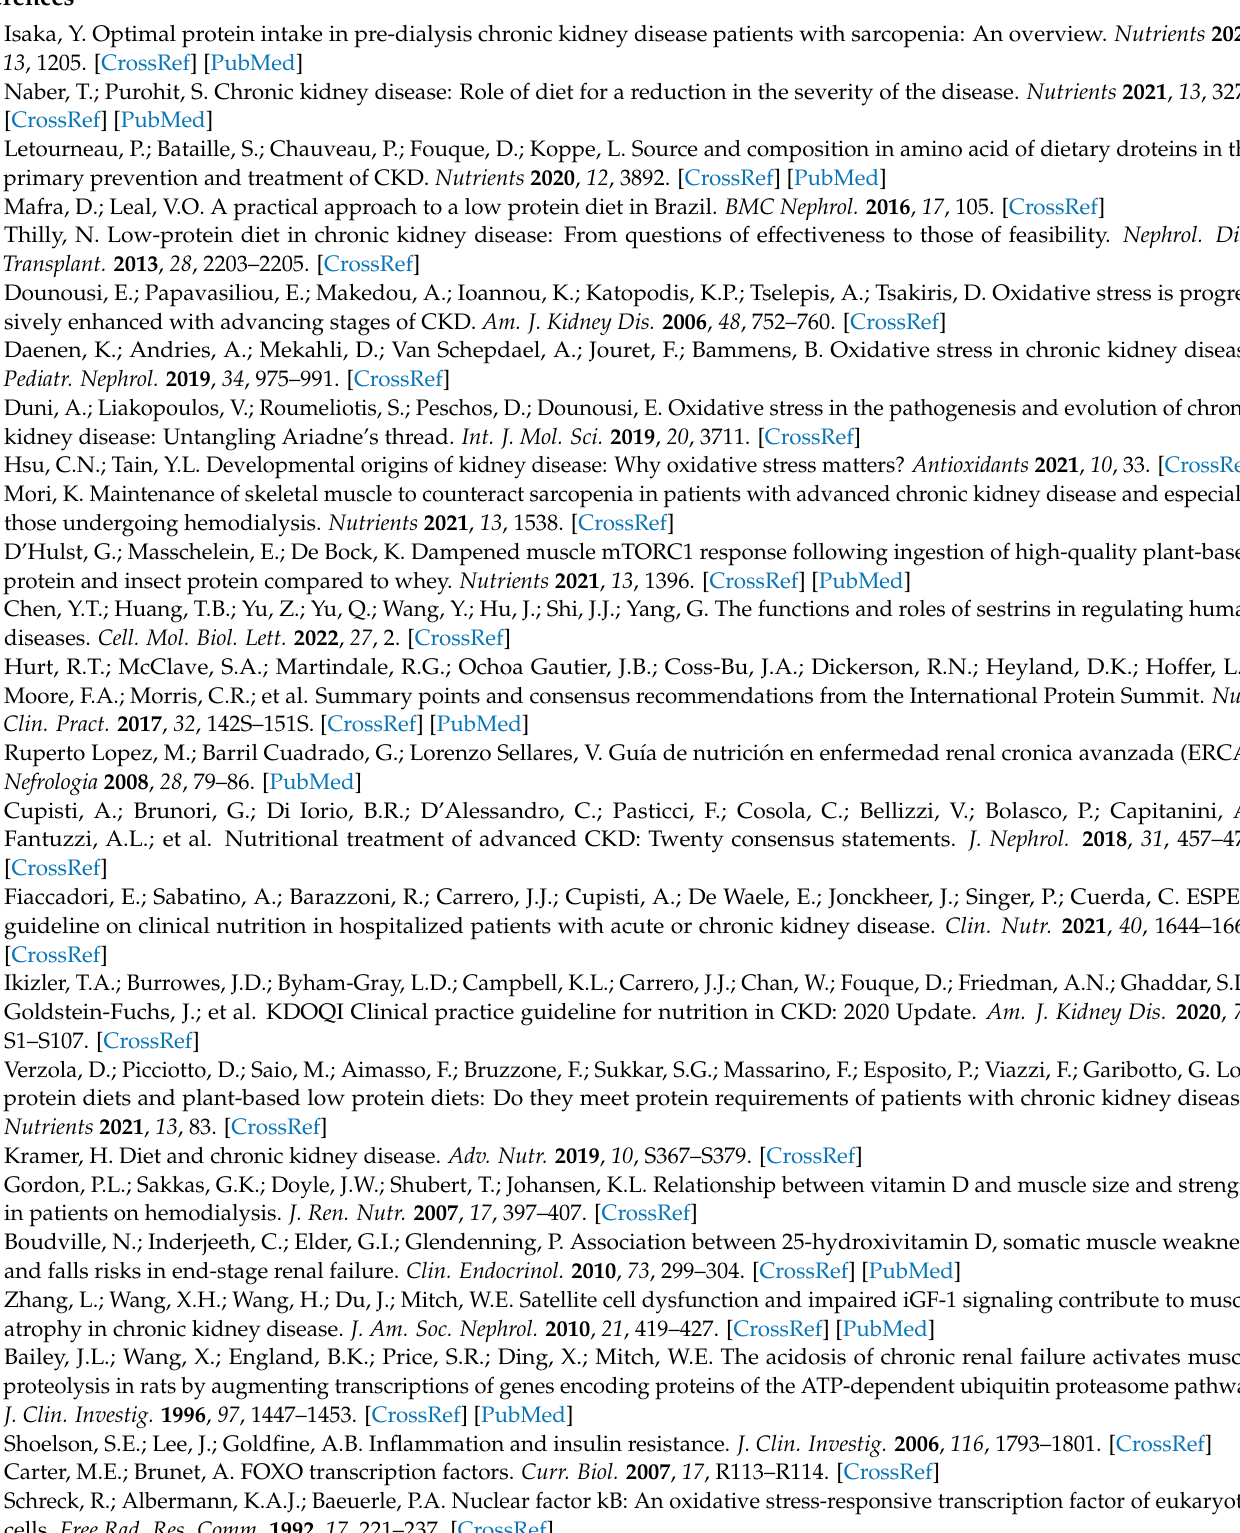
Species; S6K1 : Ribosomal Protein S6 Kinase beta-1; SREBP : Sterol Regulatory Element-Binding Protein; TGF- β : Transforming Growth Factor- β ; TNF α : Tumor Necrosis Factor alpha; VCAM-1 : Vascular Cell Adhesion